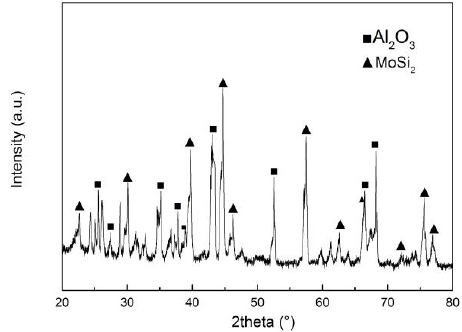
Figure 3. X-ray diffraction of the Al 2 O 3 –MoSi 2 mix powder.